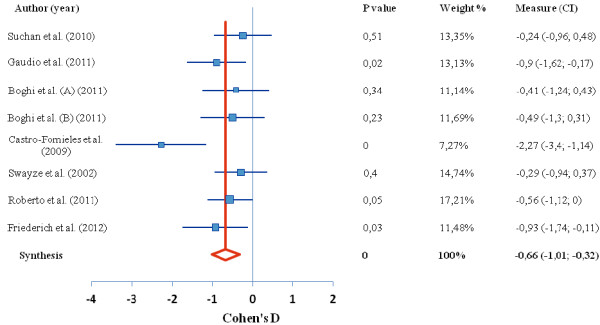
Difference in GM volume between anorexia nervosa and control group. Forest plot depicting the difference in global grey matter volume between patients with AN and healthy controls. Authors of study are given on left, red line indicates median, blue boxes indicate separate studies; p value = statistical significance threshold; weight % as adjusted for study population size; CI = confidence intervals.